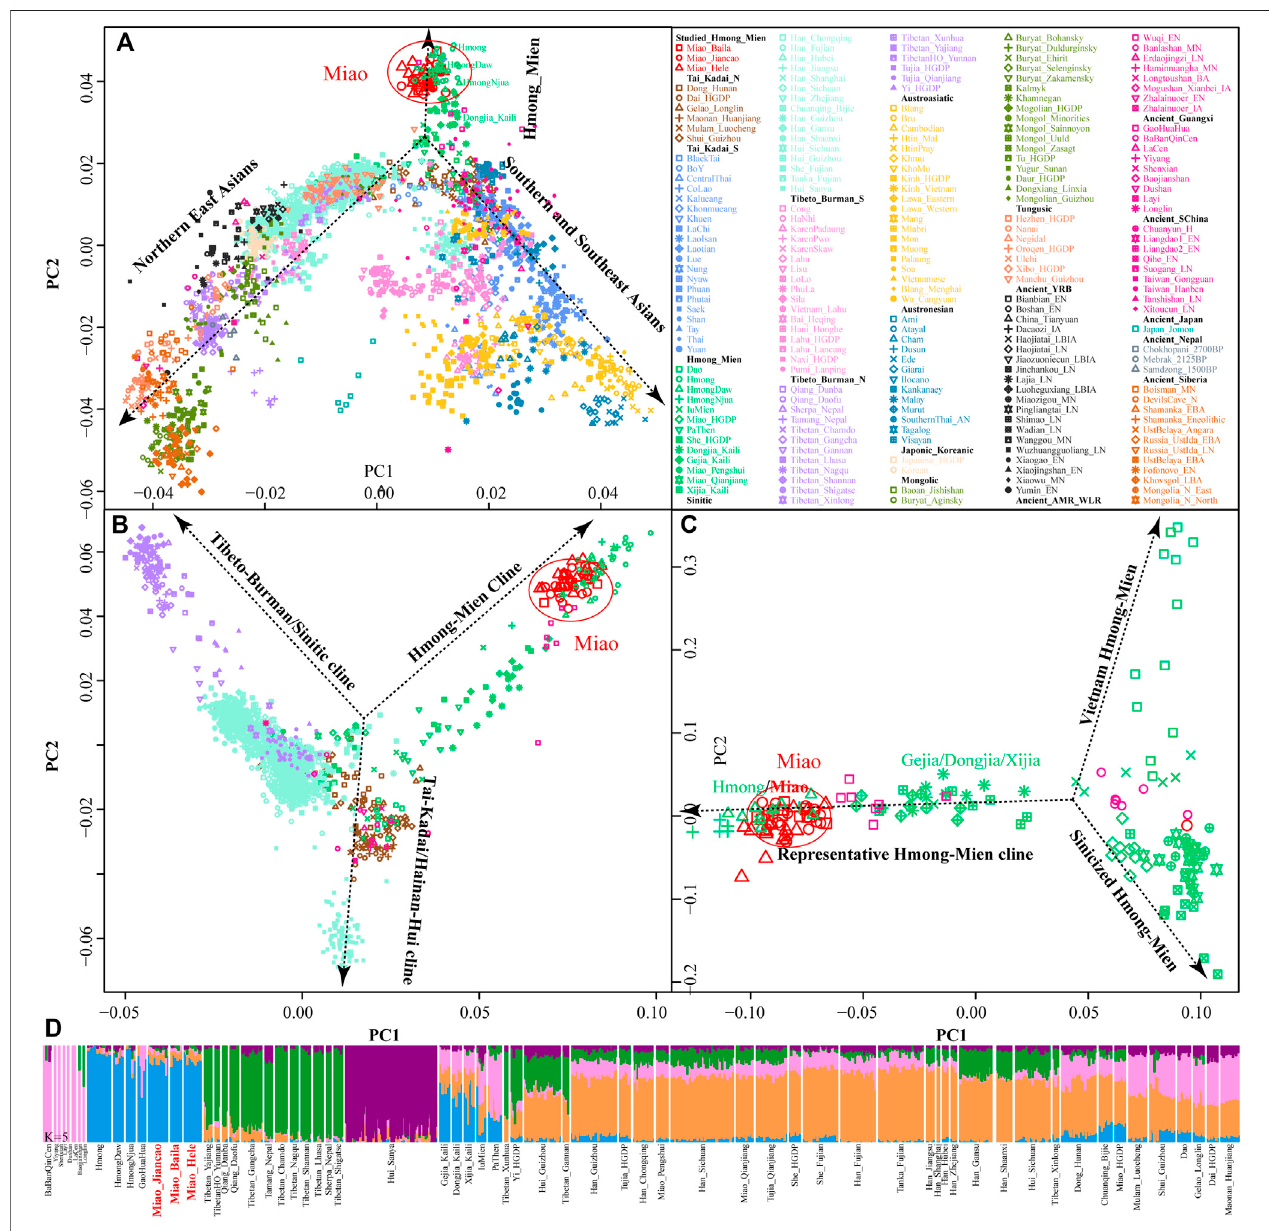
FIGURE 1 | Genetic af fi nity of HM people in the context of modern and ancient eastern Eurasians. (A – C) , Principal component analyses focused on the genetic diversity from East Asian, South Chinese populations, and HM-speaking populations. Included East Asian ancient populations were projected onto the modern genetic background. Populations were color-coded based on geographical and linguistic categories. (D) Model-based ADMIXTURE results with fi ve prede fi ned ancestral sources showed the ancestral cluttering pattern and their individual ancestral proportion.